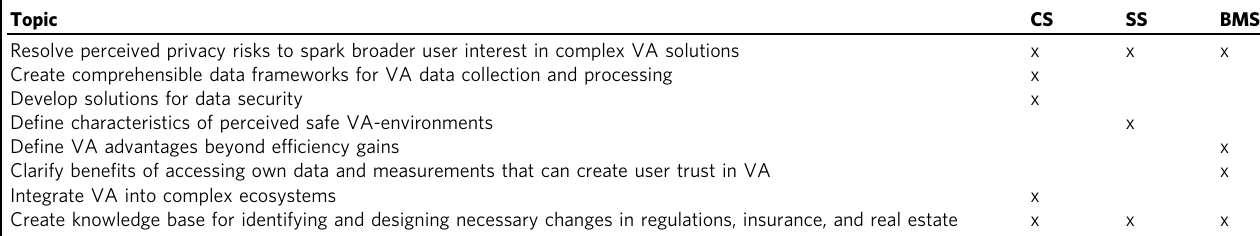
Table 6 Main VA challenges and related domain-speci fi c research contributions.